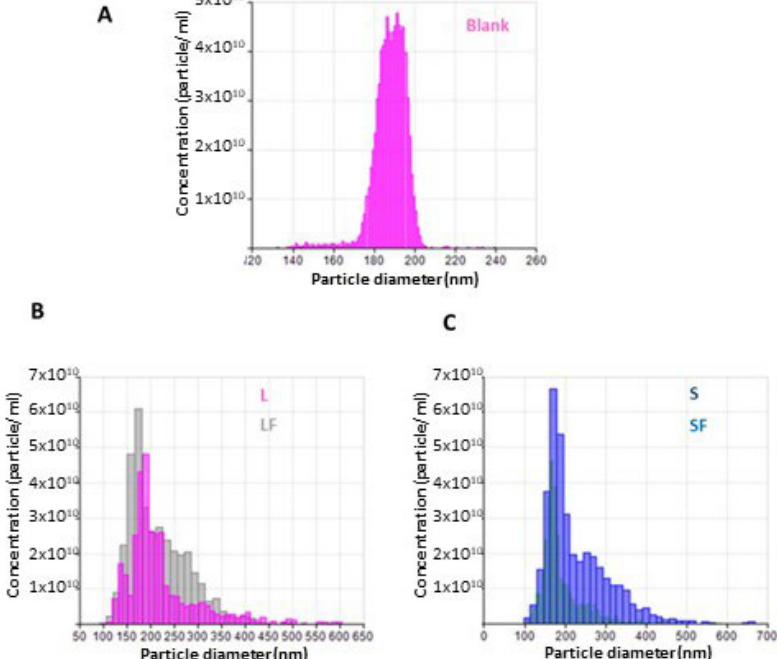
Figure 5. Size distribution and concentration of the investigated NPs. ( A ) Blank NPs without BBR; ( B ) NPs with BBR-L (L), NPs with BBR-L and with a folic acid coating (LF); ( C ) NPs with BBR-S (S) and with a folic acid coating (SF). Size (in nm) and concentration (particles/mL) are reported on X- and Y-axes, respectively.